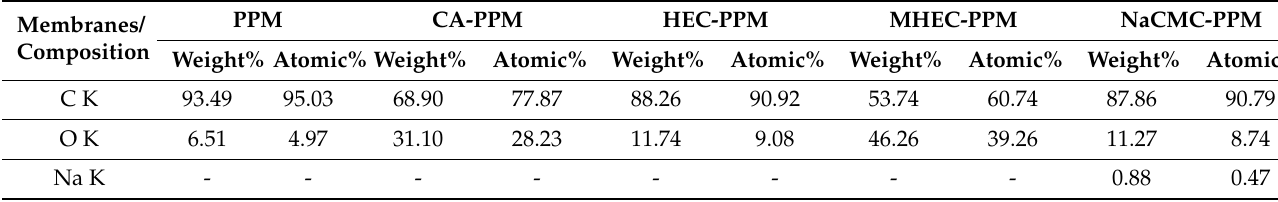
Table 7. The surface composition of the prepared impregnated membranes.